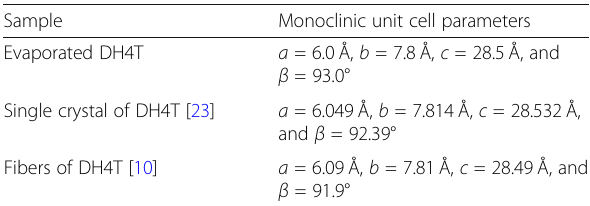
Table 1 The unit cell parameters for the DH4T oligothiophene for the room-temperature crystalline phase Sample